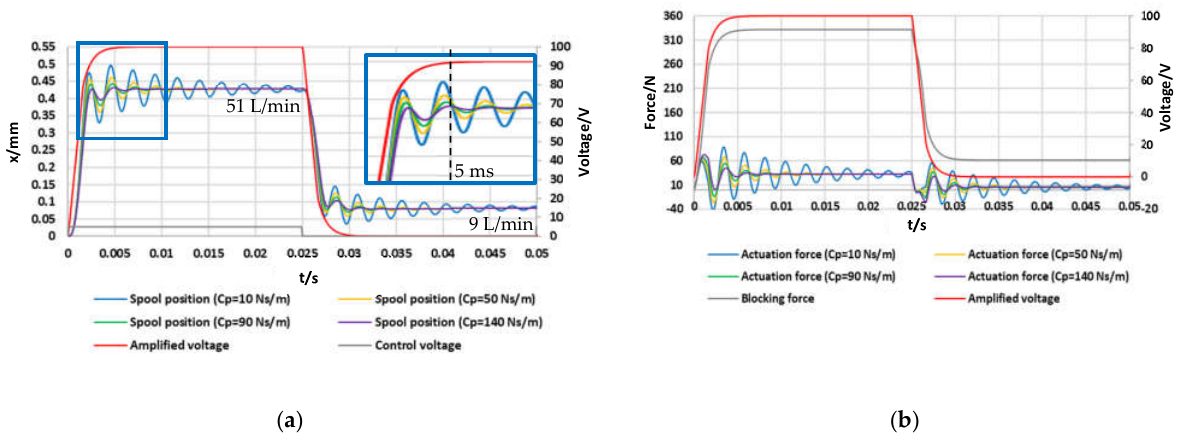
Figure 7. Open-loop step tests simulated for different values of C p and ω n , a = 2800 rad/s ( m p = 80 g; p P − p T = 70 bar): ( a ) spool position; ( b ) actuation force.